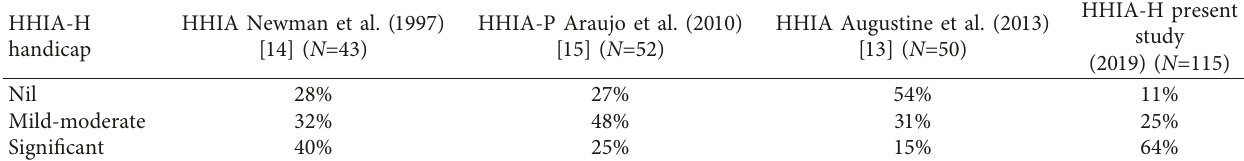
Table 2: HHIA handicap comparison among different